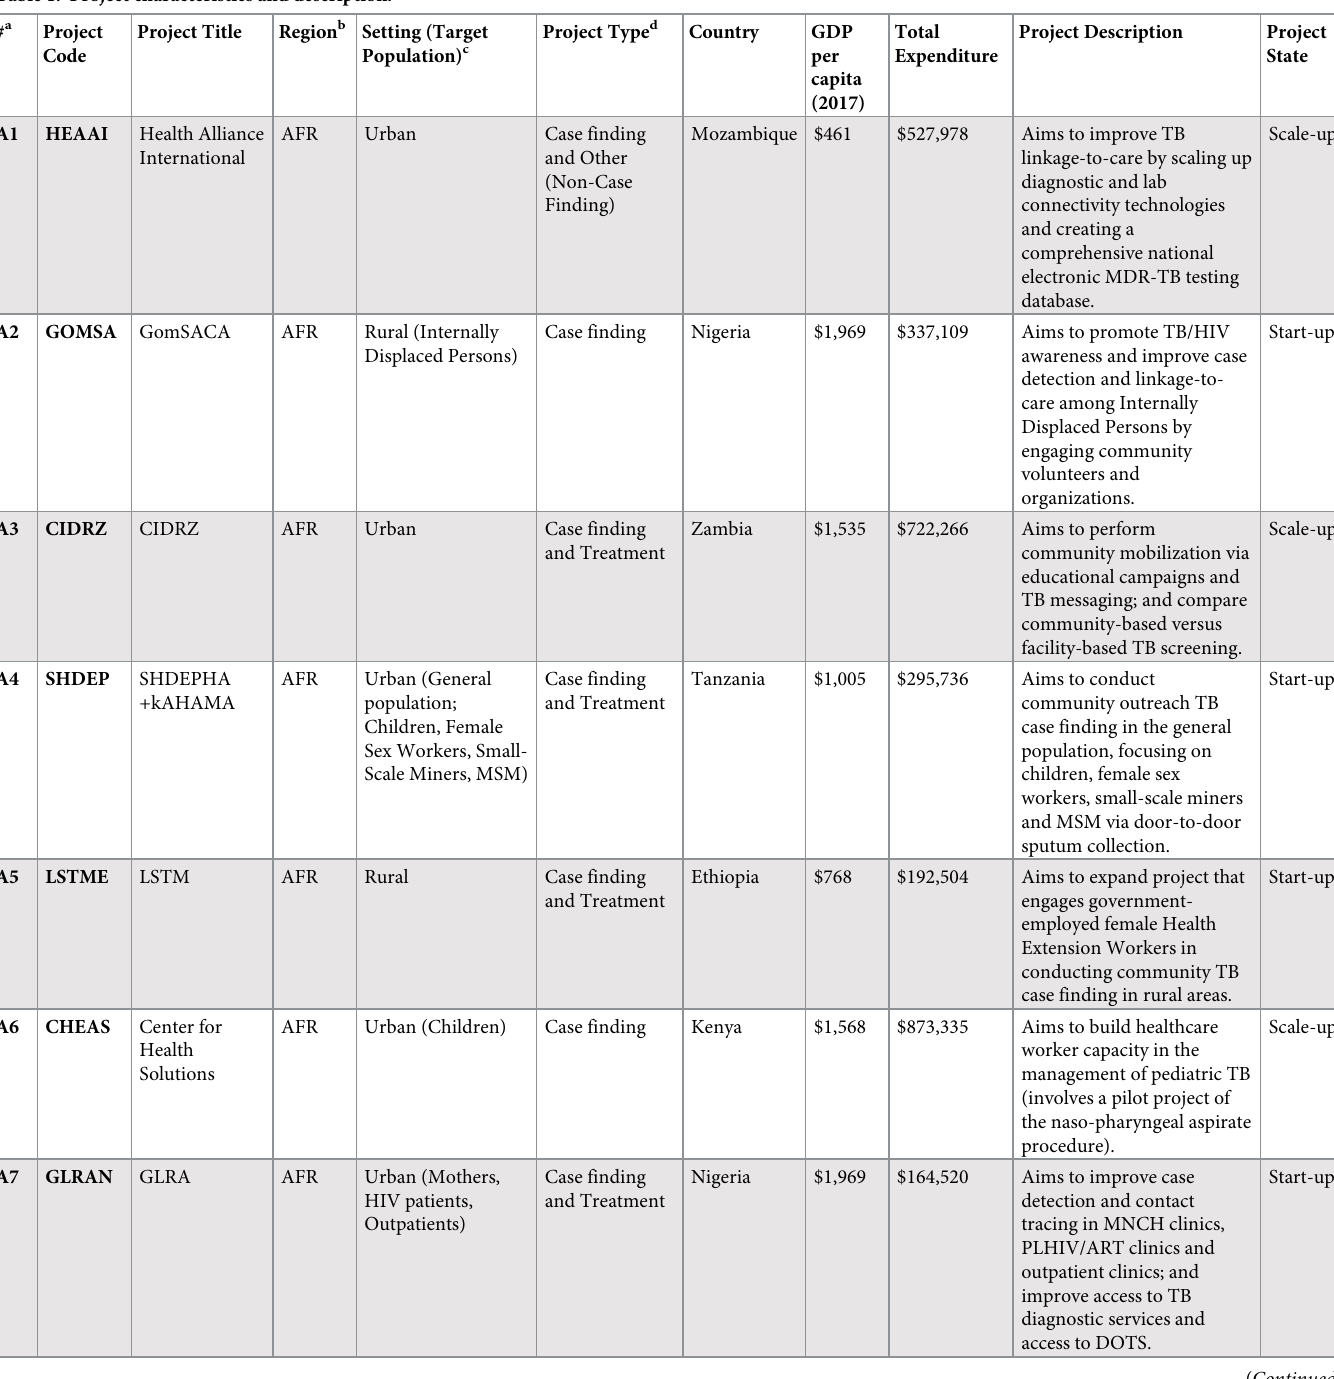
Table 1. Project characteristics and